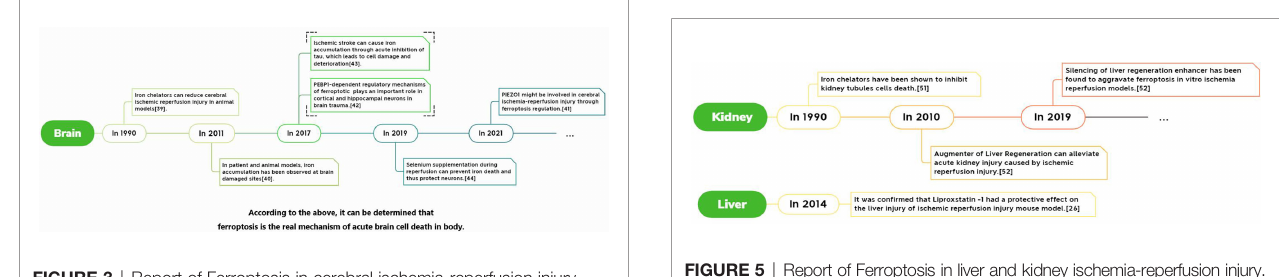
FIGURE 3 | Report of Ferroptosis in cerebral ischemia-reperfusion injury.